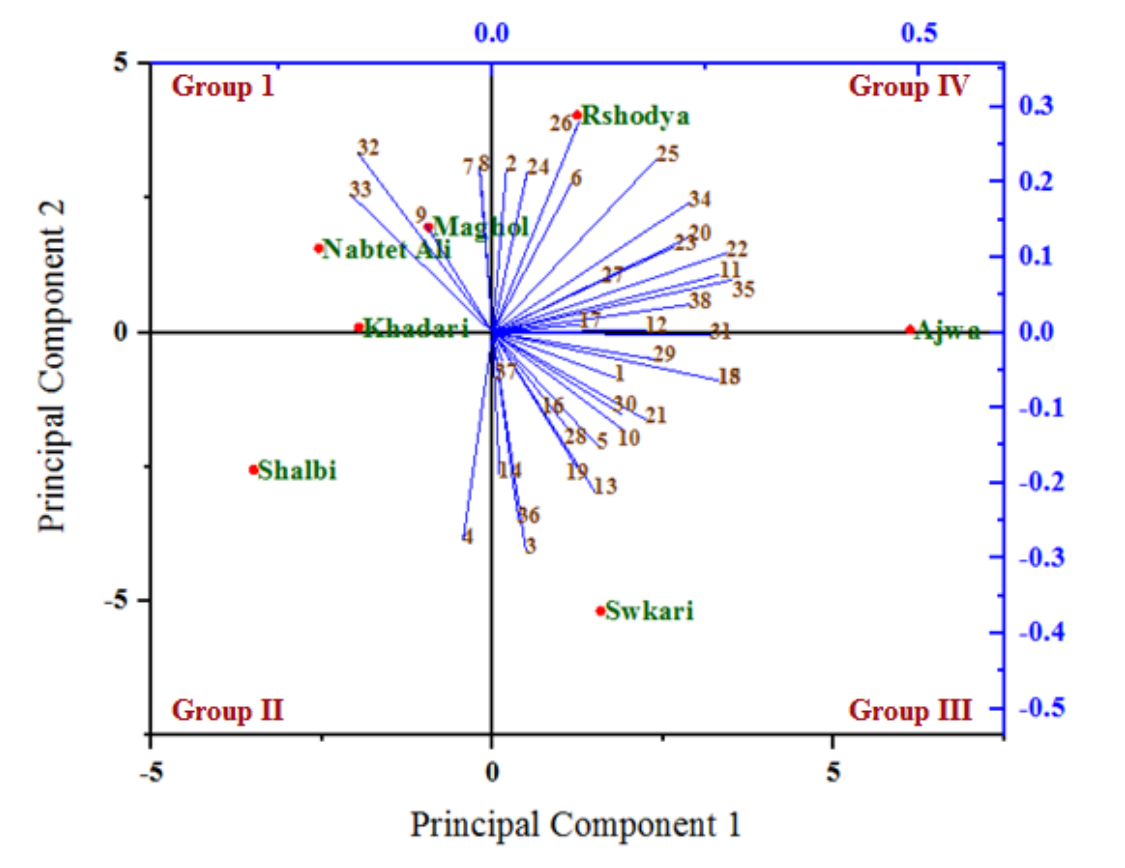
Figure 7. A biplot diagram based on PC1 and PC2 shows similarities and dissimilarities in rela ‐ tionships among the measured variables across different varieties of palm dates under after SDBD plasma treatment. 1—Ash%; 2—Total fat %DW; 3—Total protein%; 4—Total sugar %; 5—Total